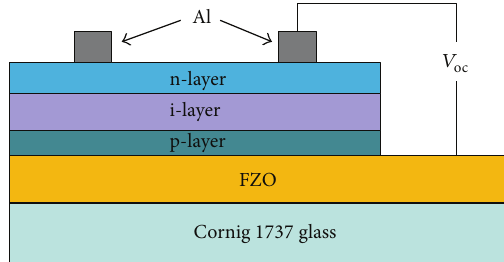
Figure 7: Structure configuration of the hydrogenated amorphous silicon thin film solar